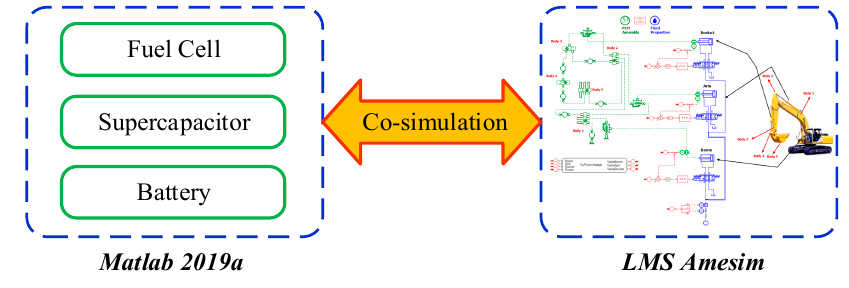
Figure 8. Co-simulation environment.